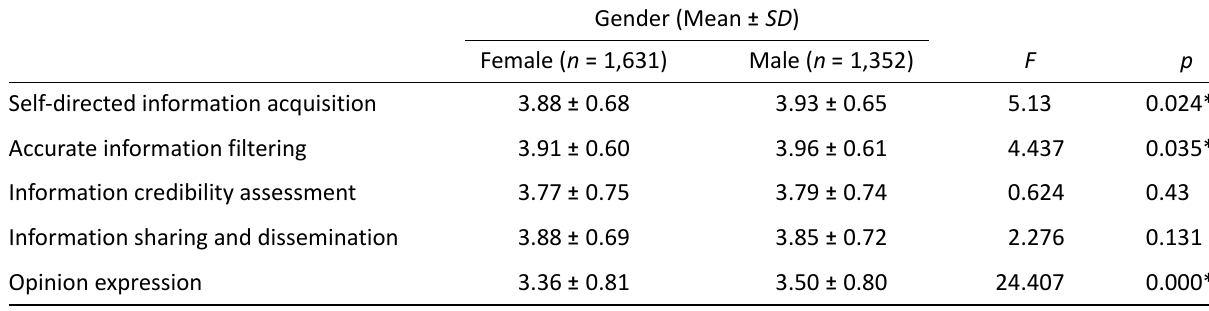
Table 7. Gender differences in levels of information